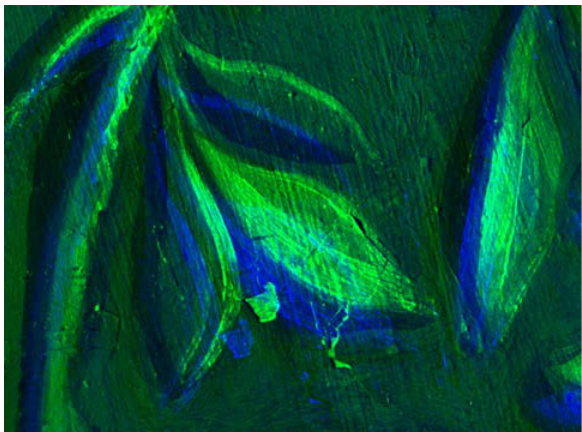
Figure 4. The effect of the misalignment of images is clear in this false-coloured composite of a detail of image 1 (green) and image 5 (blue). The offset is 45 pixels in X and 73 pixels in Y.